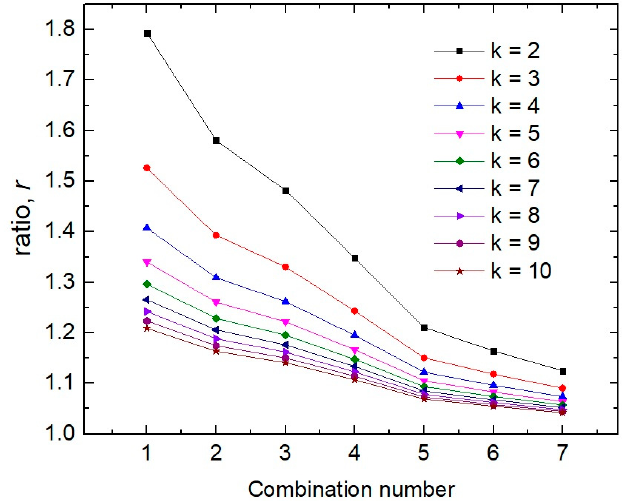
Figure 2. Percentile ratio, 𝑟 , versus the percentile combination number. The legend for the combination number is: 1 (p1-p50-p99), 2 (p3-p50-p97), 3 (p5-p50-p95), 4 (p10-p50-p90), 5 (p20-p50-p80), 6 (p25-p50-p75), and 7 Table 1. R atios (r) for different combinations of percentile. As demonstrated above, these ratios are independent of the values of B chosen in Equations (1) and (2).